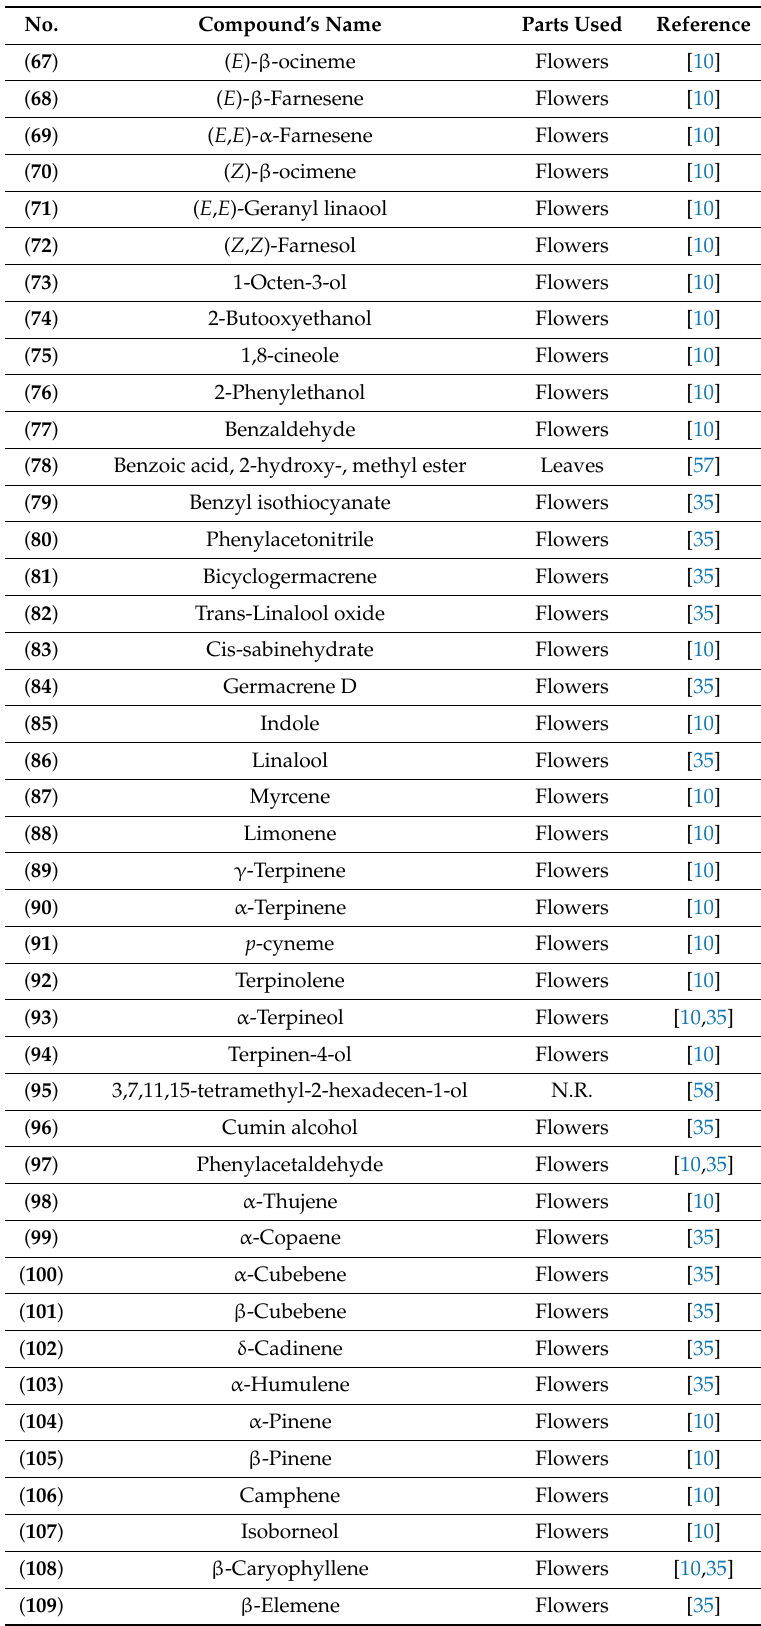
Table 4. The volatile compounds from A. cathartica